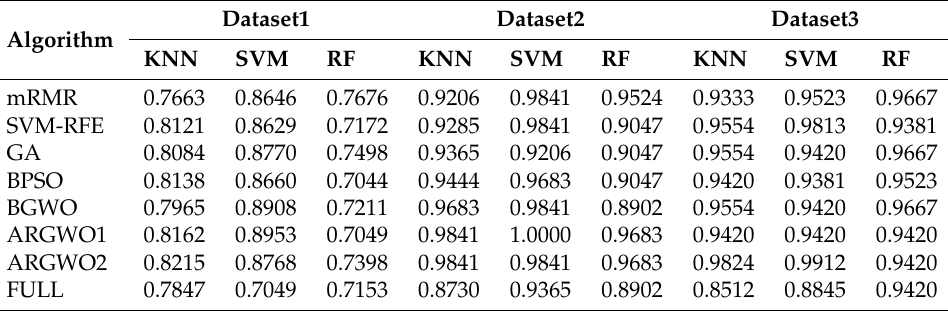
Table 7. Classification accuracy comparison of various methods in the training set.